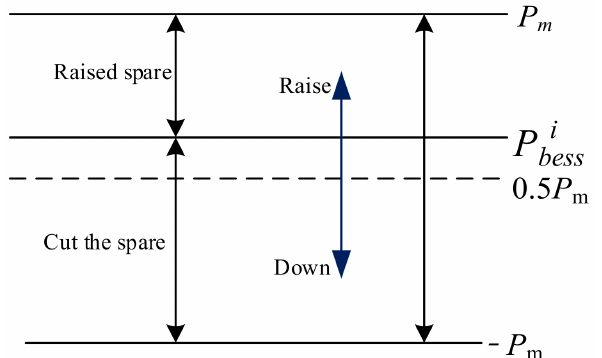
Figure 5. Schematic diagram of power up- and